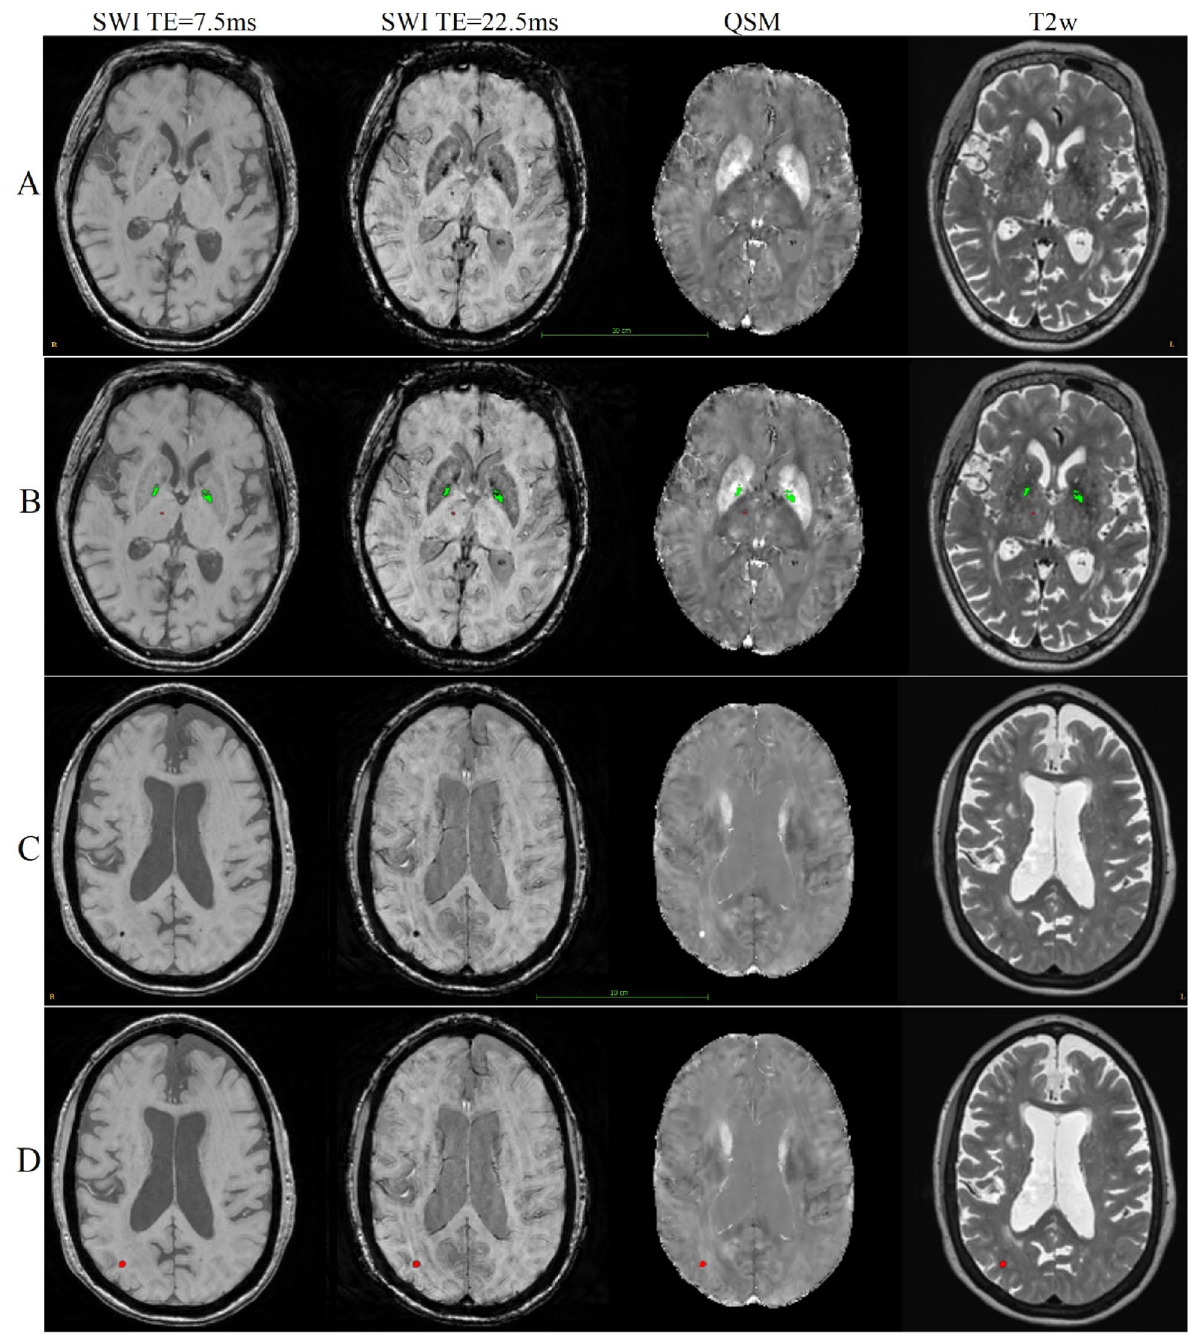
Figure 4. This figure shows examples of cerebral microbleeds and basal ganglia iron deposition in SWI for TE = 7.5 ms (left column), SWI for TE = 22.5 ms (middle left column), QSM (middle right column) and T2w (right column). ( A , C ) Show the lesions in two different brains, and ( B , D ) show the corresponding human expert labeling of the CMBs (red) and iron deposits were 13 males and 11 females with age range 65–94 years. Based on the expert annotation of these 24 participants, 4 participants had no microbleeds, 13 participants had 1 or 2 microbleeds (with an average size of 10.85 mm 3 ), 6 participants had between 3 and 8 microbleeds (with an average size of 10.21 mm 3 ) and 1 participant had more than 100 microbleeds (with an average size of 4.76 mm 3 ). In certain circumstances, the participant with more than 100 microbleeds may be considered an outlier in terms of the number of CMBs. An examination of this is presented in Sect. 3 of the “Supplementary materials”. Of the 24 participants, 5 participants did not have any voxels labeled as non-hemorrhage iron deposits and the remaining had between 2 (each having a single voxel or 1.5 mm 3 ) and 13 lesions (one participant had 4 non-hemorrhage iron deposit lesions with a total of 326 voxels or 489 mm 3 ) labeled as non-hemorrhage iron deposits in the basal ganglia.